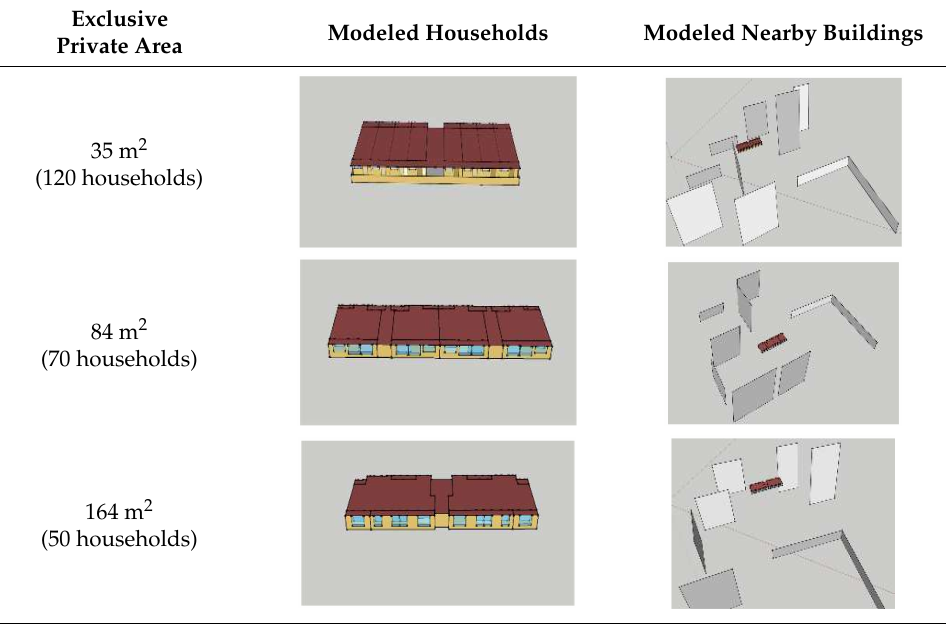
Table 1. Selection by type of apartment for